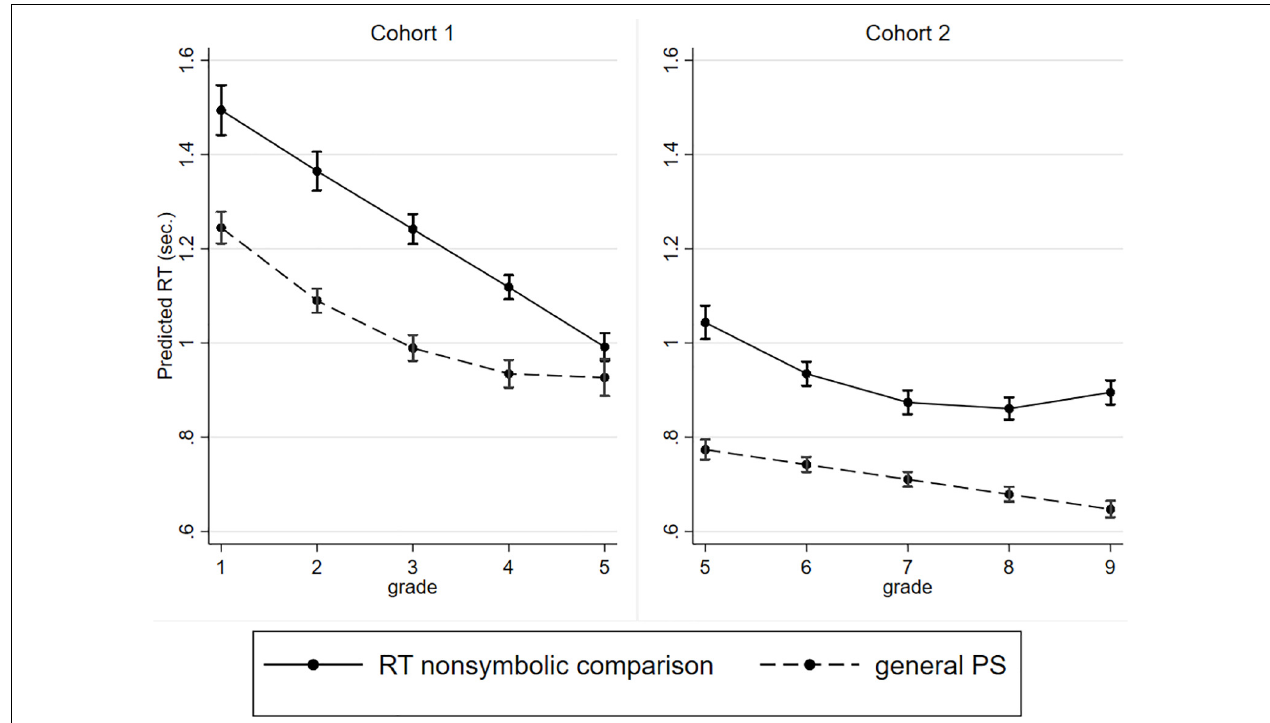
FIGURE 3 | Developmental changes in RT for the ANS test and for the general PS test (in second) with 95%